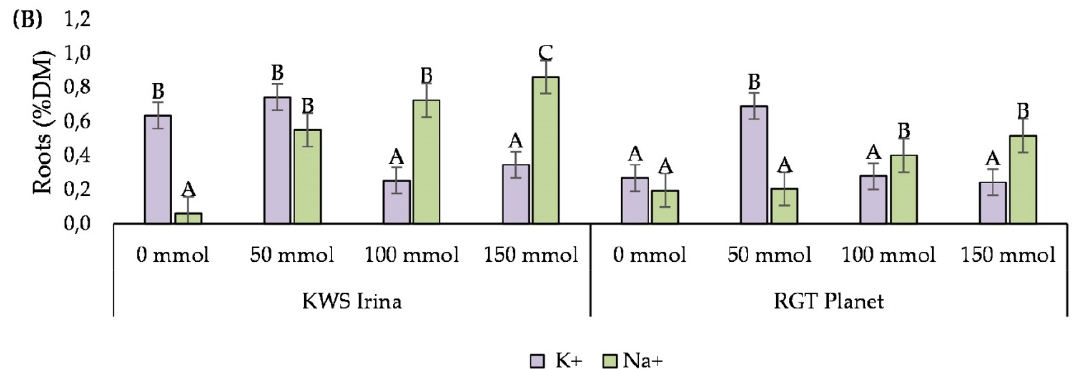
Figure 5. Potassium (K + ) and sodium (Na + ) content in the leaves ( A ) and roots ( B ) of barley plants depending on the NaCl (mmol NaCl (dm 3 ) − 1 ) concentration used. Capital letters indicate significant differences between the means in the for particular NaCl concentrations ( p = 0.05).